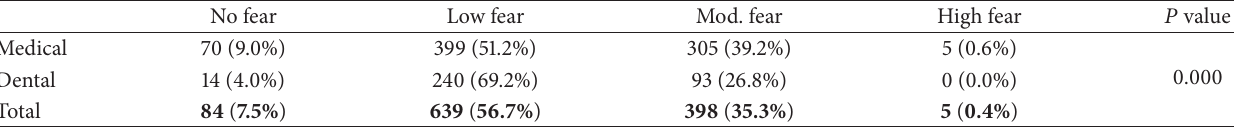
Table 3: Respondents’ level of